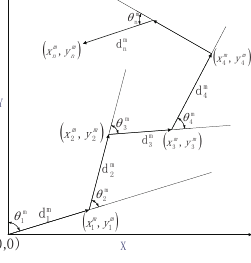
Figure 1. Expression of relative measurement and position in polar